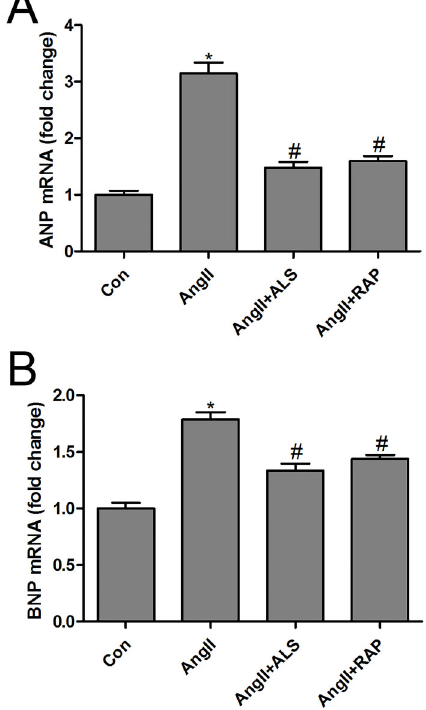
Figure 5. Aliskiren (ALS) decreased the markers of cardiac hypertrophy in Ang II-treated H9C2 cardiomyocytes. The mRNA expression of ( A ) ANP and ( B ) BNP was measured by RT-qPCR in the H9C2 cardiomyocytes after treatment with Ang II (10 m M), Ang II (10 m M) + ALS (20 m M), or Ang II (10 m M) + RAP (100 nM) for 48 h (n=3 per group). Data are reported as means ± SE. *P o 0.05 compared with control; # P o 0.05 compared with the Ang II-treated group (ANOVA followed by Tukey ’ s post hoc test). Ang: angiotensin; ANP: atrial natriuretic peptide; BNP: brain natriuretic peptide; RT-qPCR: reverse transcription-quantitative polymerase chain